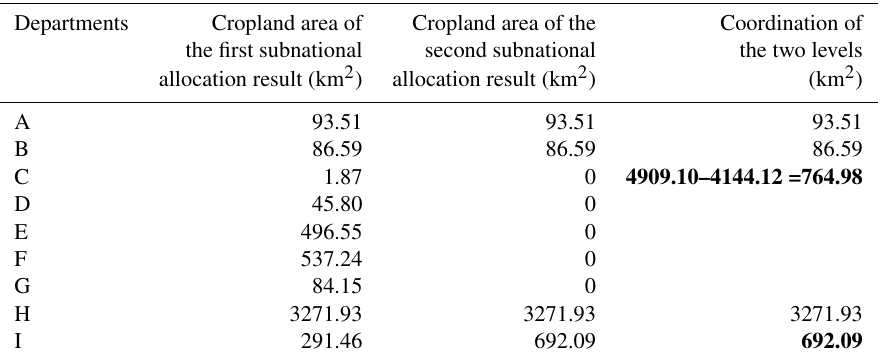
Figure 3. The integration of the first and second subnational allocation results in San Luis Province, Argentina: (a) the first subnational allocation result, (b) the second subnational allocation result, (c) the combination of the departments with no statistics, and (d) the allocation results of the departments with no statistics. Table 3. Cropland areas of each department from the first and second subnational allocation results and their coordination (values in bold) in San Luis Province of